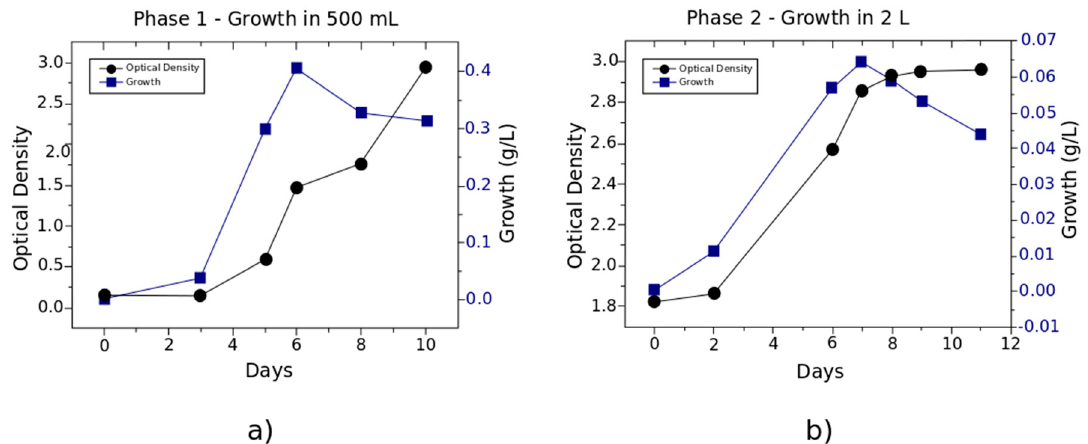
Figure 4. Optical density and growth of S. capricornutum cultivated in the glass flask reactor ( a ) and in the photobioreactor ( b ). Table 4. Biomass productivity of Selenastrum capricornutum.